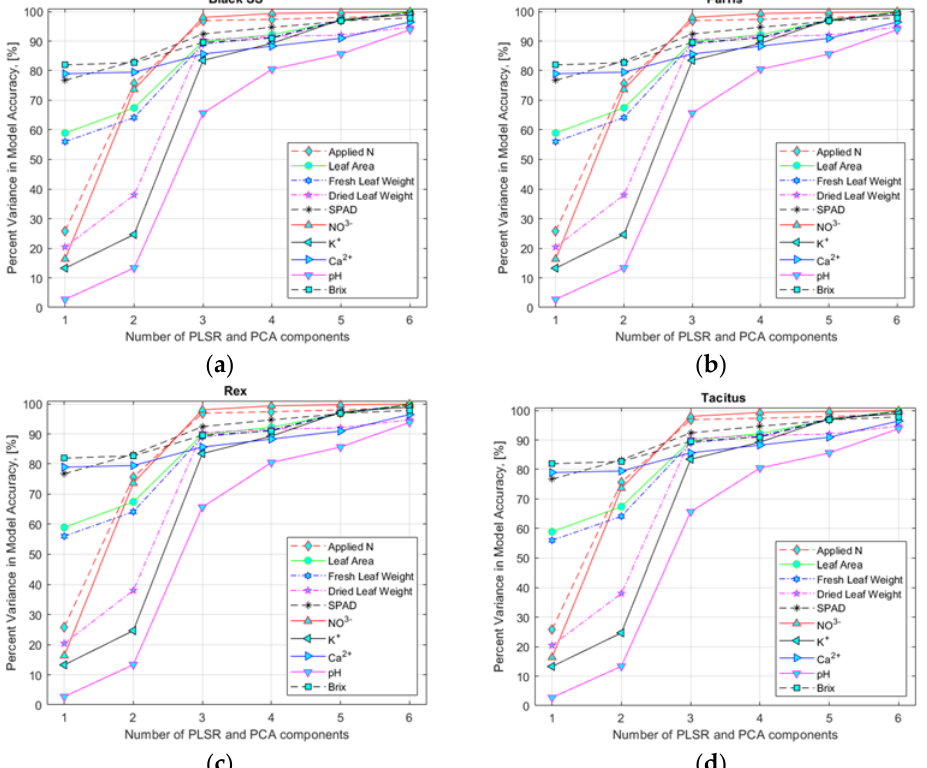
Figure 6. Selection of the number of predictor variable components using the PLSR and PCA models